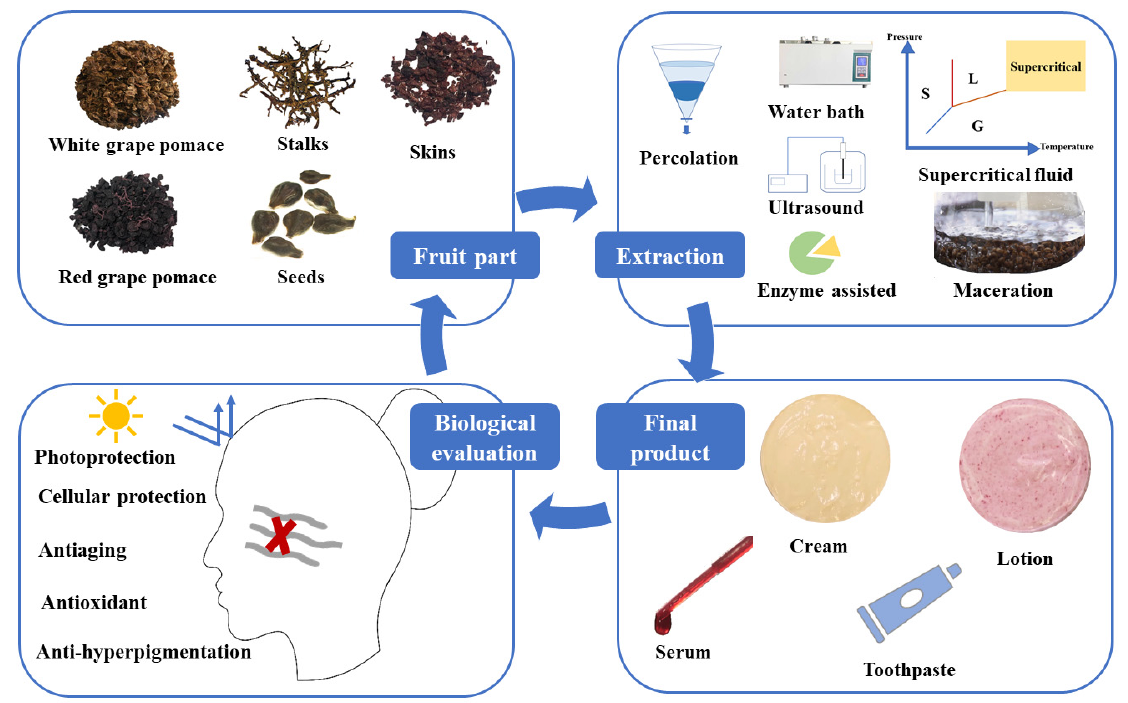
Figure 3. Schematic representation of the life cycle of Vitis vinifera , starting by the studied by-product, then the extraction technique, the cosmetics products in which polyphenols were formulated and finally the acquired biological activities.